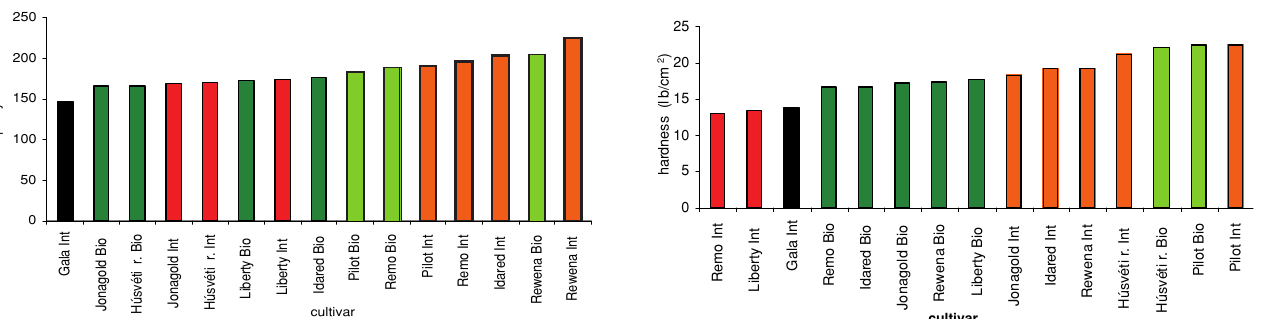
Figure 2. The range of samples according to the quality index (Debrecen, 2008)